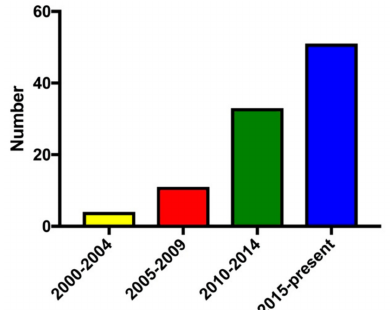
Figure 1. Number of college genomic education publications since 2000: Ninety-nine studies from 2000 to 2019 were surveyed. Of the 99 published studies, 4 were published between 2000 and 2004, 11 were published between 2005 and 2009, 33 were published between 2010 and 2014, and 55 were published in the last five years (2015 to present).